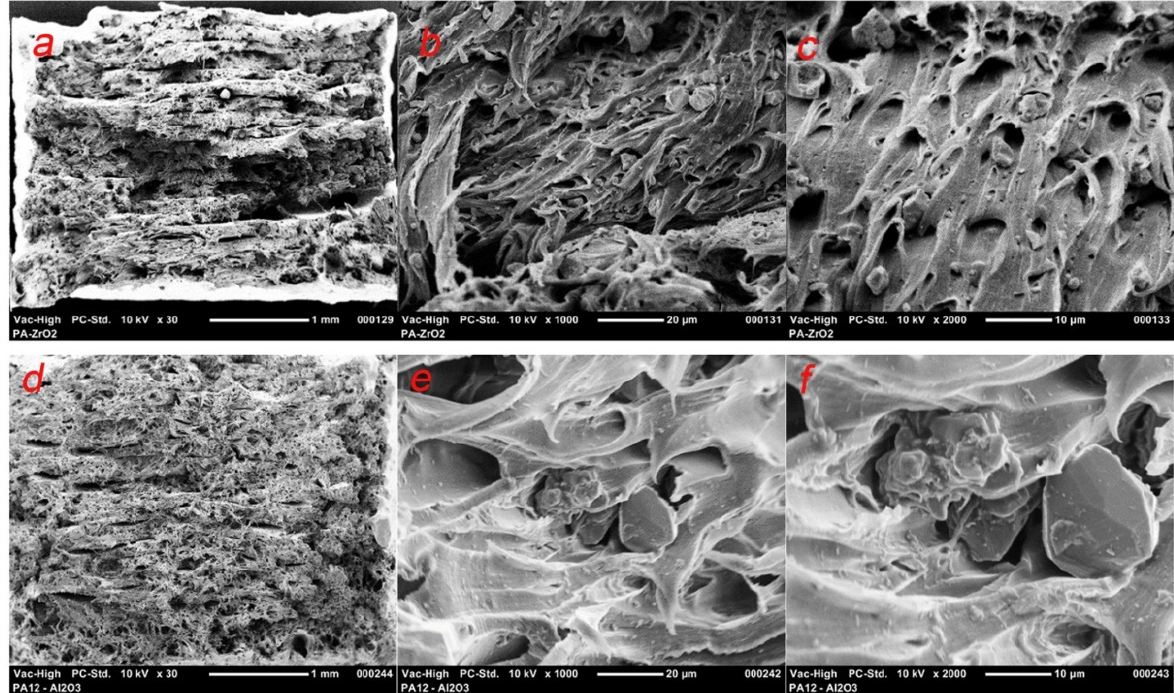
Figure 13. SEM micrographs of the fracture surface of PA12-ZrO 2 at magnifications of ×30 ( a ), ×1000 ( b ), and ×2000 ( c ); PA12-Al 2 O 3 at magnifications of ×30 ( d ), ×1000 ( e ), and ×2000 ( f ).